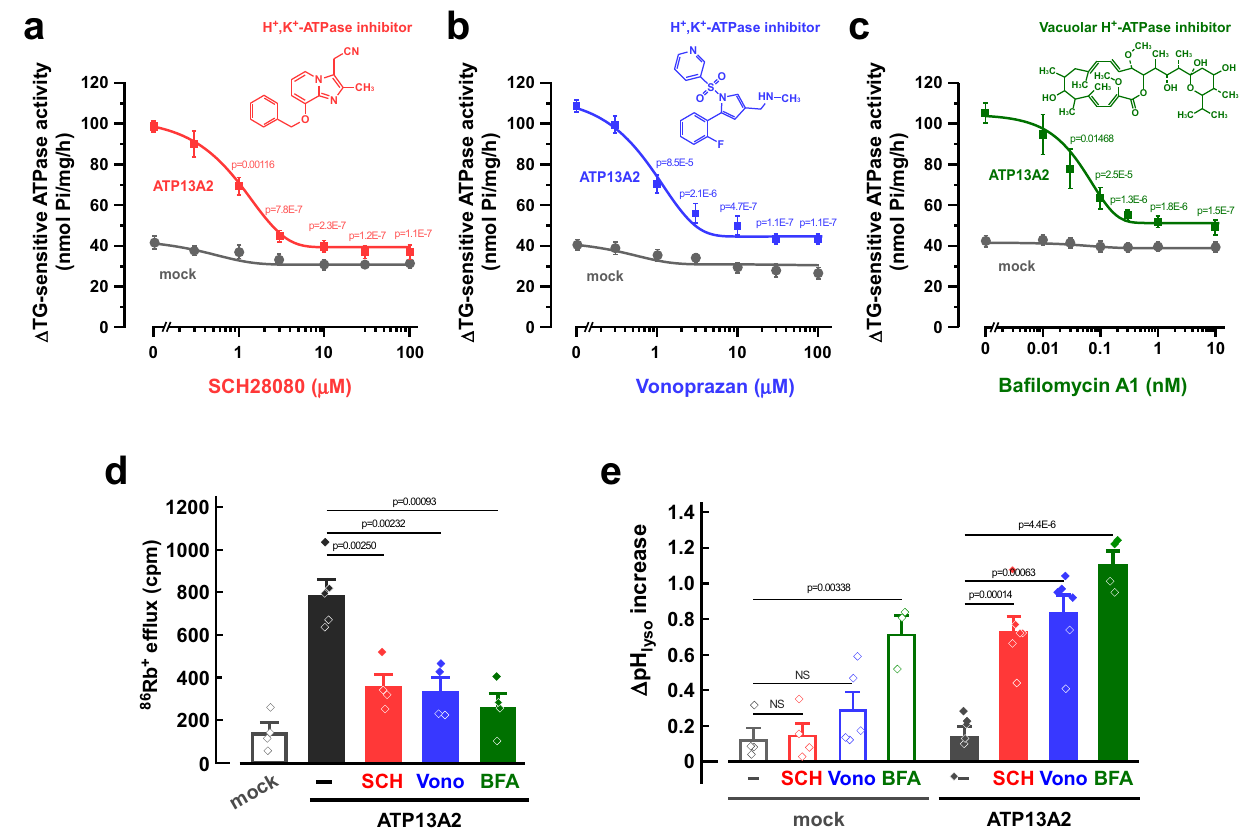
Fig. 3 | Effects of inhibitors of gastric H + ,K + -ATPase (P-CABs) and vacuolar H + -ATPase on exogenous ATP13A2 activity in HEK293 cells. a – c Concentration- dependent effects of SCH28080 ( a ),vonoprazan( b ),and ba fi lomycin A1( c ) on the Δ TG-sensitive ATPase activity in the ATP13A2- and mock-transfected HEK293 cells. ( n =3 – 6 independent replicates). Statistical signi fi cance was determined by one- way ANOVA. d Effects of SCH28080 (SCH; 10 μ M), vonoprazan (Vono; 10 μ M), ba fi lomycin (BFA; 5nM) on the ATP-dependent 86 Rb + ef fl ux from lysosomes of the ATP13A2-transfected HEK293 cells. ( n =4 – 5 independent replicates). Statistical